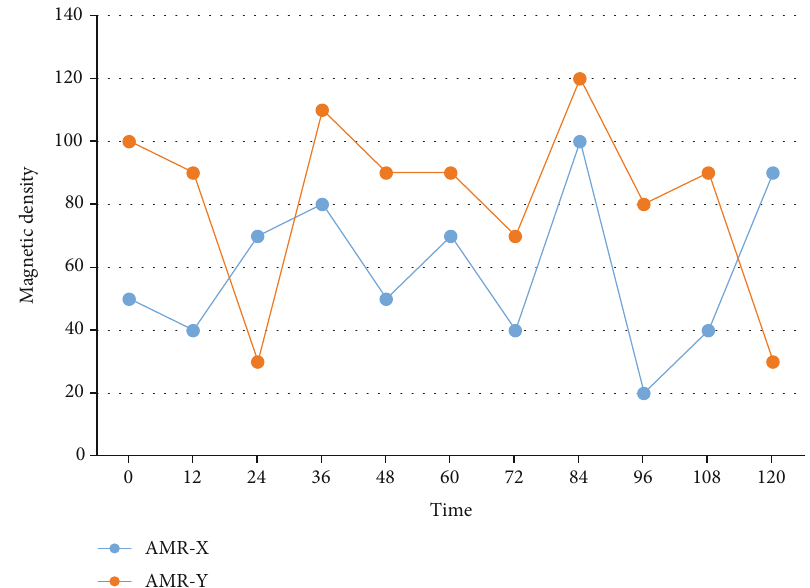
Figure 5: Comparison of AMR-X and AMR-Y fi ltered signals.